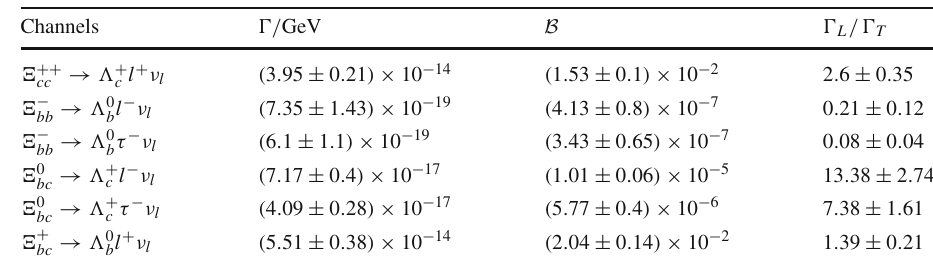
Table 6 Decay widths and branching ratios of the semi-leptonic (cid:3) QQ (cid:3) → (cid:2) Q (cid:3) l ν l decays, where l = e